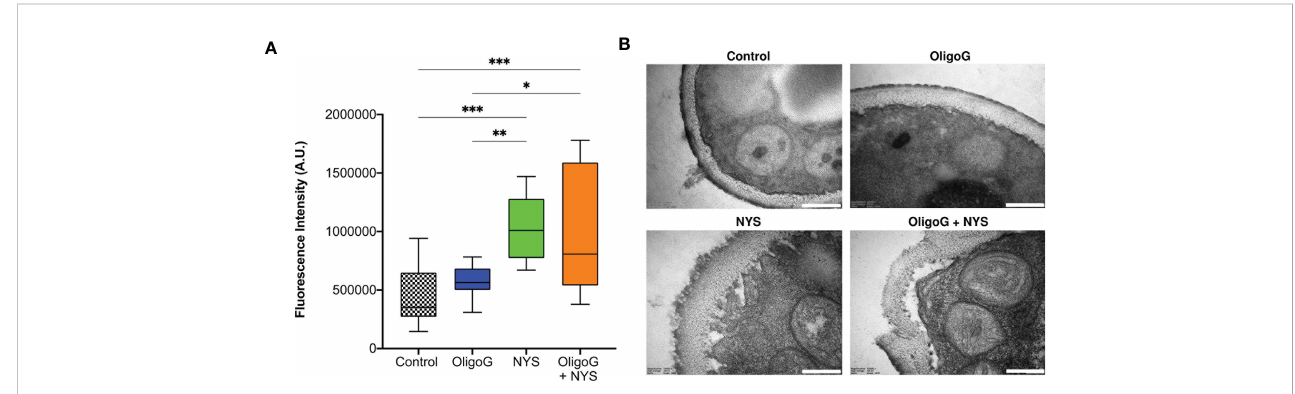
FIGURE 6 (A) Fluorescence intensity data derived from PI staining used in the fungal membrane permeability assay of C. parapsilosis W23 treated ± 4% OligoG ± 1 µg/ml nystatin (NYS; n=3). Group wise comparisons were analysed using one-way ANOVA followed by Tukey ’ s post hoc tests *p < 0.05; **p < 0.01; ***p < 0.001. (B) TEM imaging of C. parapsilosis W23 treated ± 4% OligoG ± 1 µg/ml nystatin, demonstrating disruption of the cell wall with nystatin treatment; scale bar 200 nm